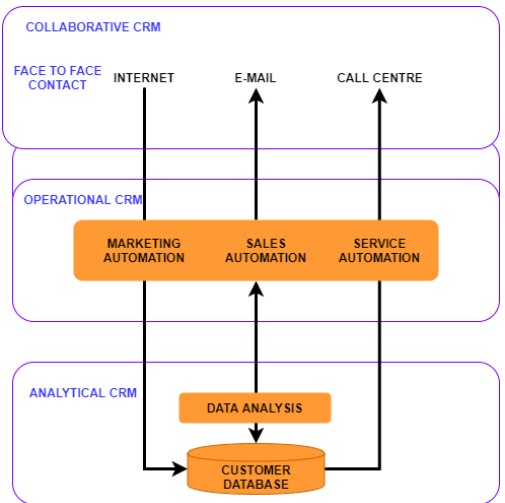
Figure 3. Four-stage Internet of Things (IoT) solution architecture [65].